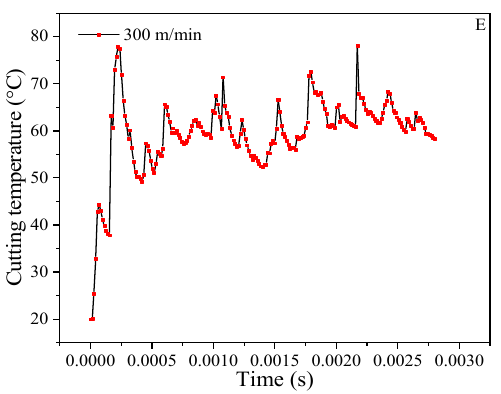
Figure 9. Cutting temperature curves at different milling speeds. ( A ) 100 m/min. ( B ) 150 m/min. ( C ) 200 m/min. ( D ) 250 m/min. ( E ) 300 m/min.